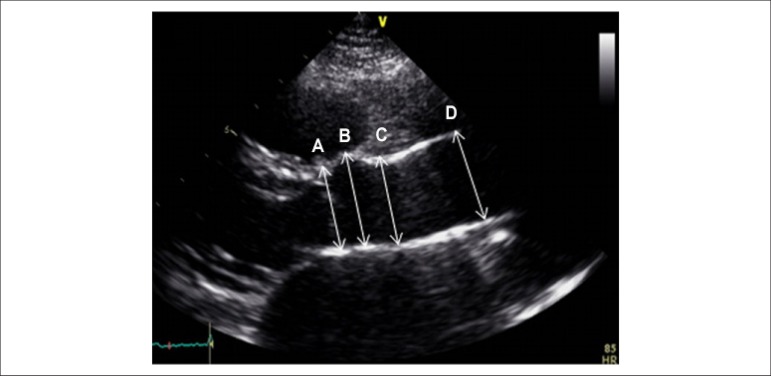
Measurements of the aorta. Two-dimensional echocardiogram of the
neo-aorta, parasternal view of the long axis of the left ventricle.
The measurement sites are shown: A- aortic annulus; B- sinus of
Valsalva; C- sinotubular region; D- ascending aorta.